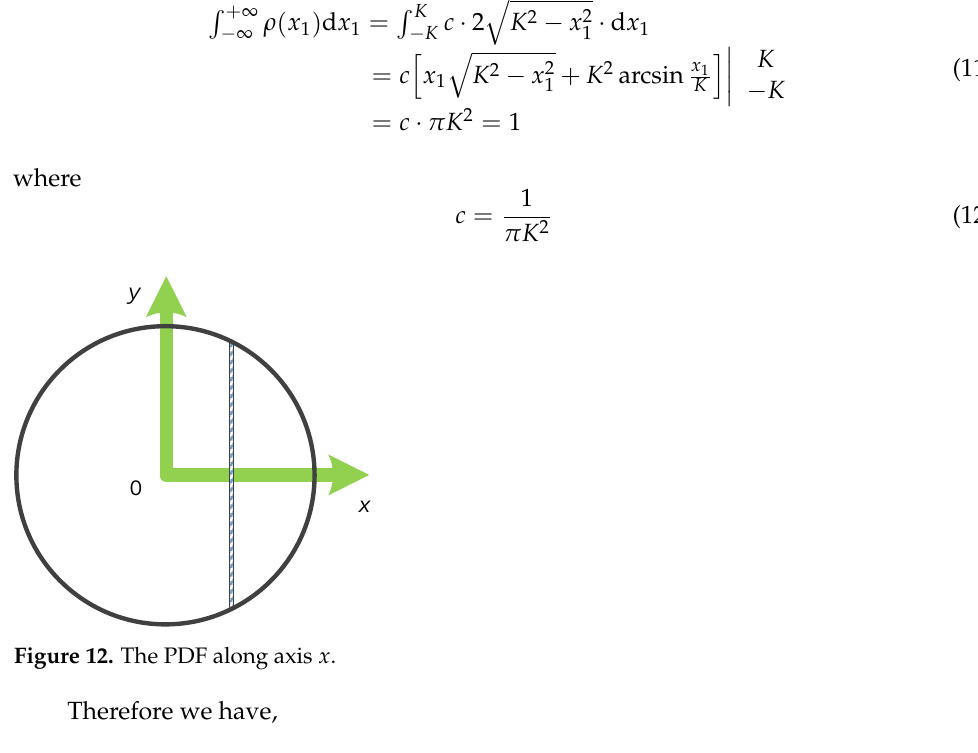
Figure 12. The PDF along axis x